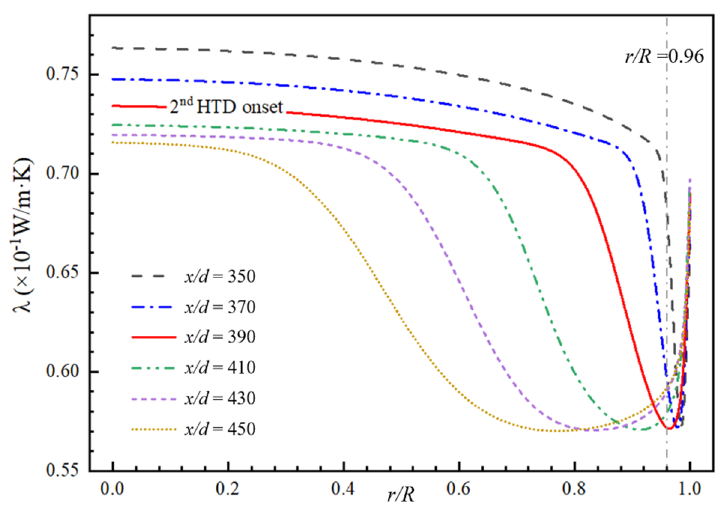
Figure 11. Radial distributions of thermal conductivity in the second HTD zone.